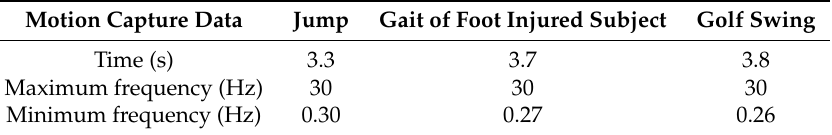
Table 2. Three different motion data for